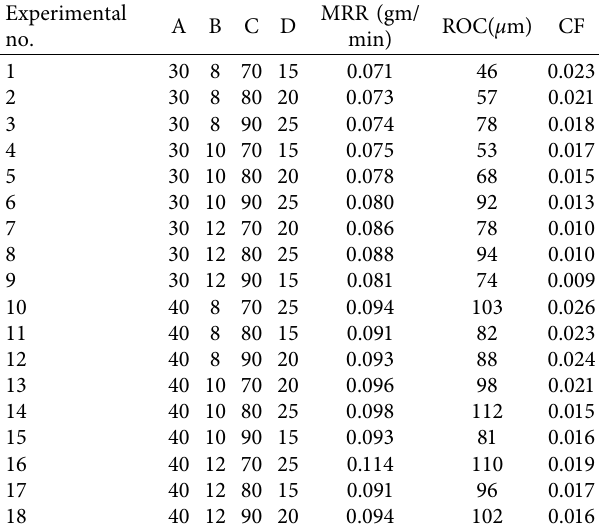
Table 4: L 18 mixed-level OA-based experimental design.